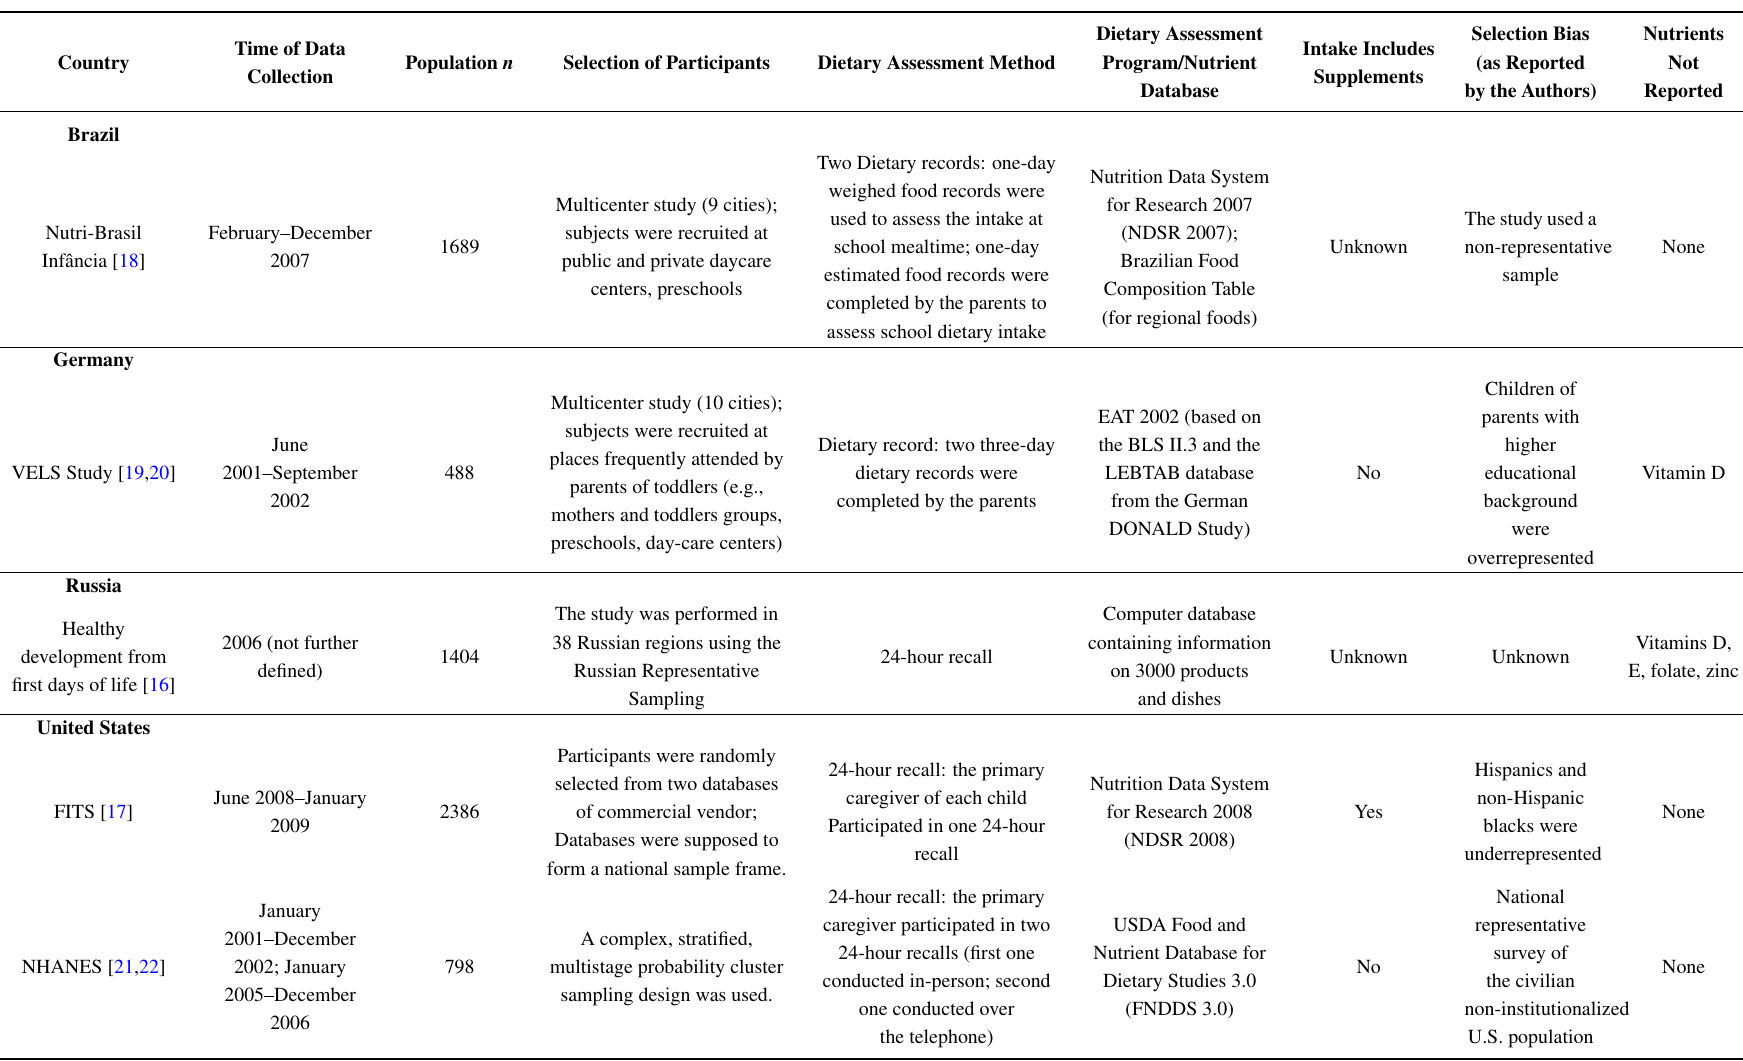
Table 2. Characteristics of the studies included in the